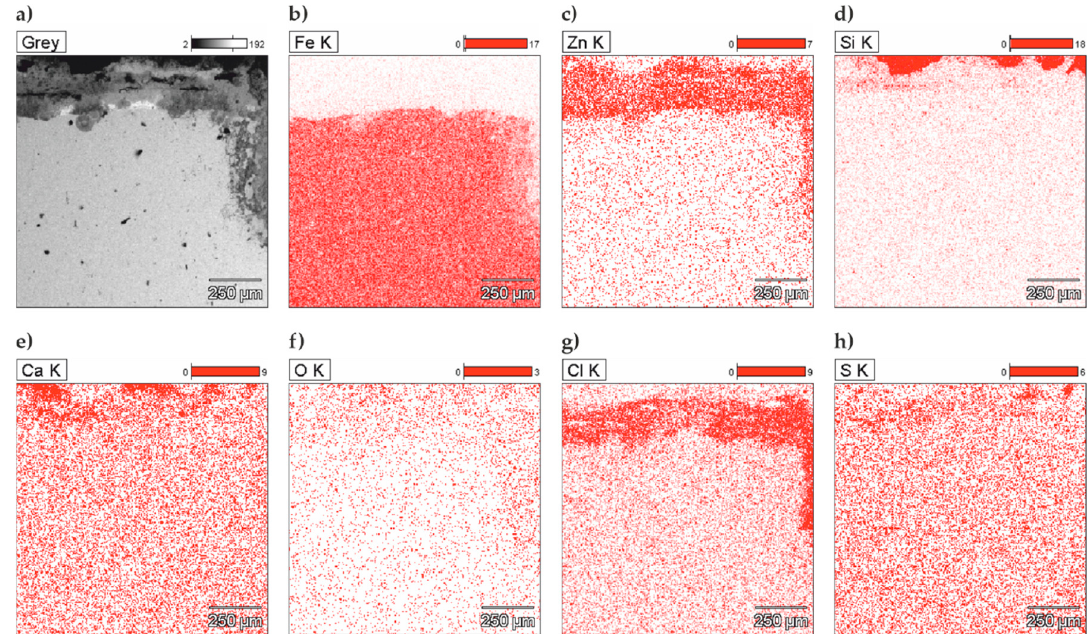
Figure 20. (a) Microstructure of the surface of tested concrete without chlorides—reinforcing steel B500SP with zinc coating (SEM) and relative concentrations of elements on the surface (mapping): ( b ) Fe, ( c ) Zn, ( d ) Si, ( e ) Ca, ( f ) O, ( g ) Cl, and ( h ) Al (EDS).